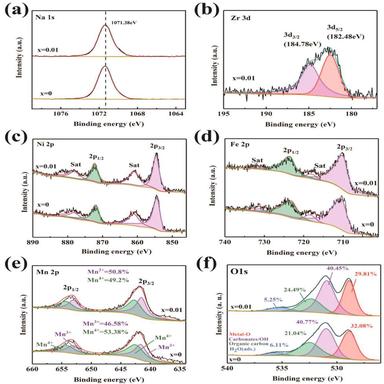
XPS spectra of (a) Na1s, (b) Zr 3d, (c)Ni 2p, (d) Fe 2p (e) Mn 2p and (f) O1s, of NFM and NFM-1 %Zr.